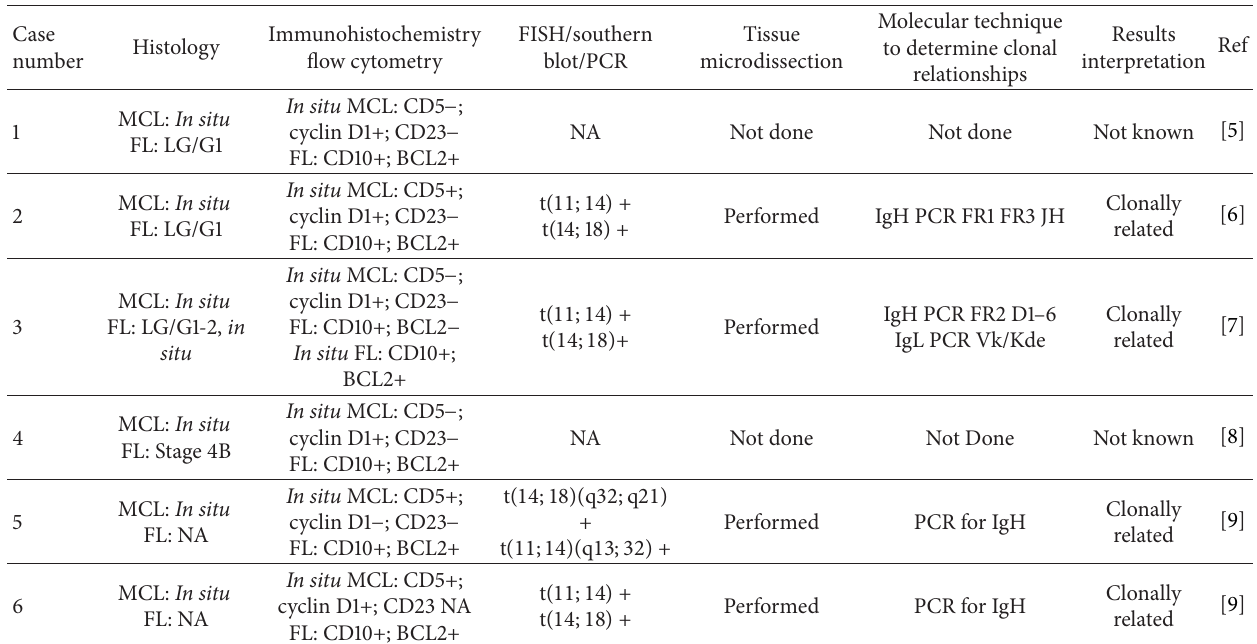
Table 2: MCL in situ with